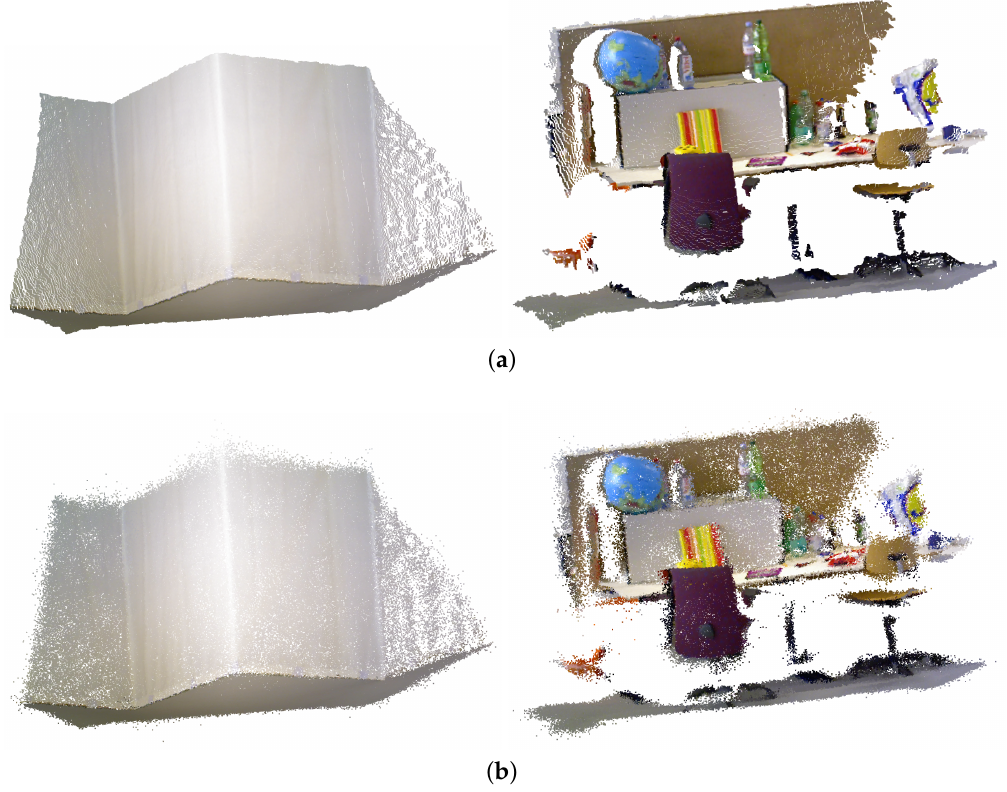
Figure 3. The raw point clouds of the RGB-D datasets and the reconstructed point clouds by our approach. ( a ) Raw point cloud; ( b ) Reconstruction using our